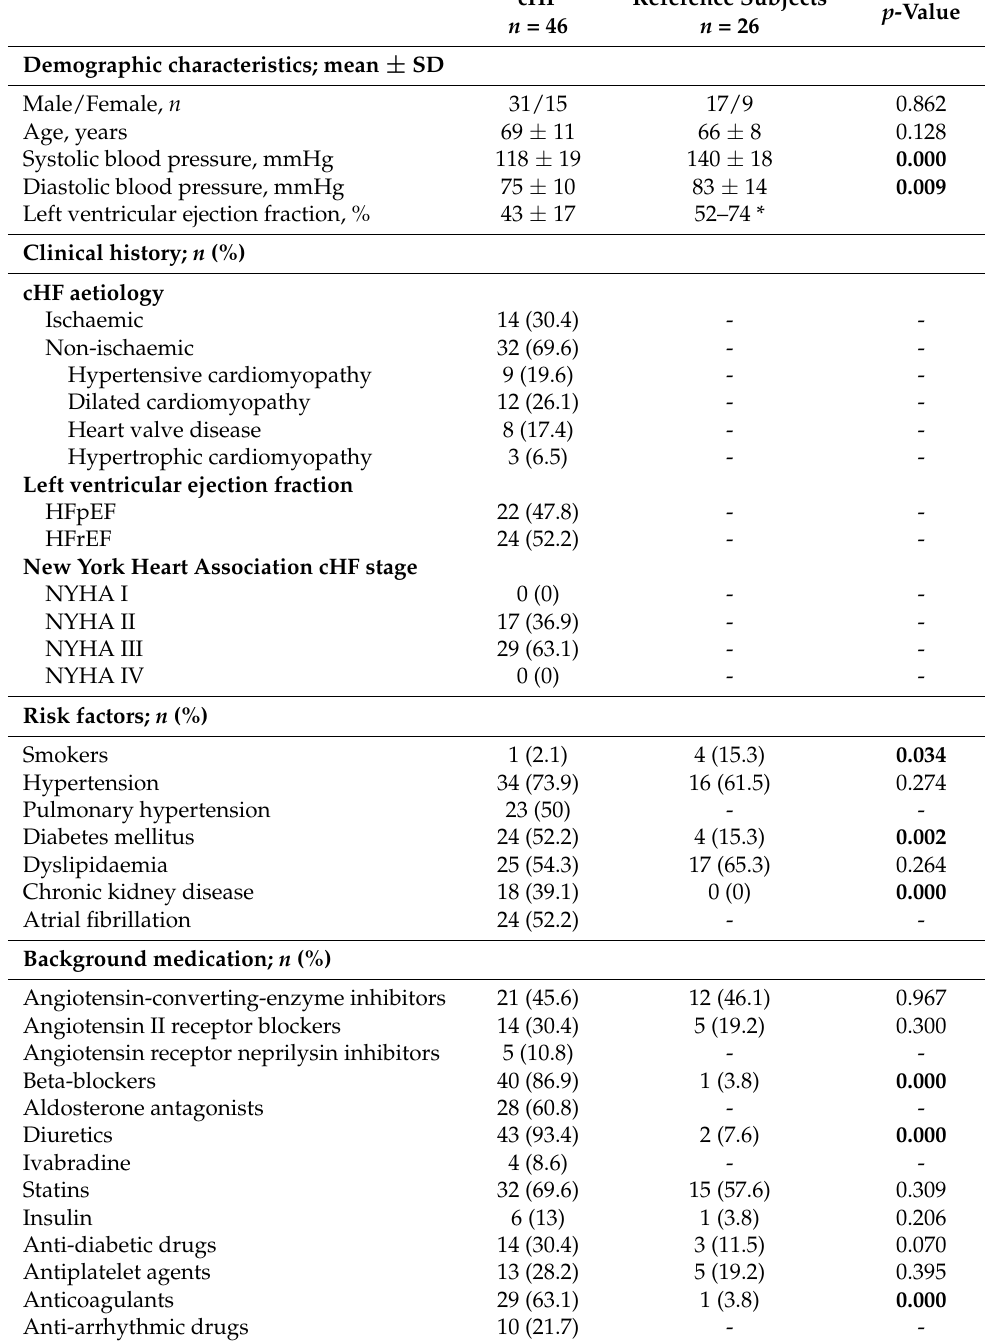
Table 6. Baseline characteristics of cHF patients and reference subjects in the miRNA